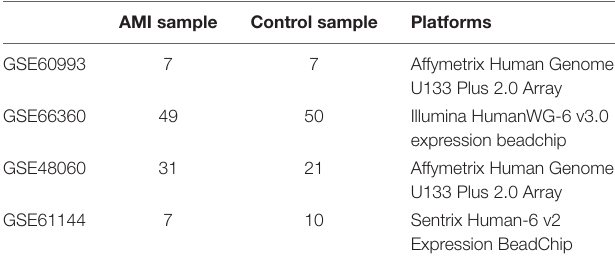
TABLE 1 | Details of the Gene Expression Omnibus (GEO) data